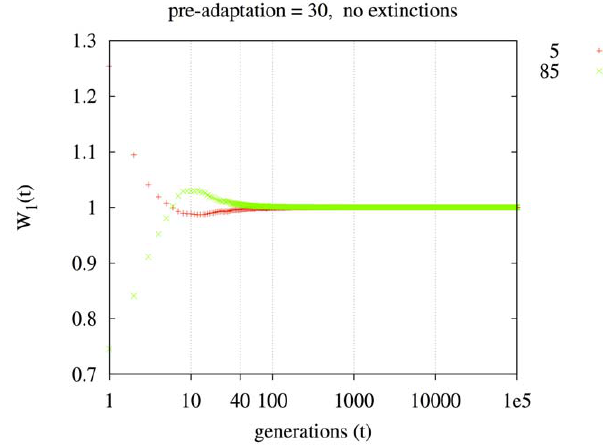
Figure 5. An initially better-adapted lineage (red, a =5) has a higher 1-fitness, W 1 t ð Þ , for t # 5. However, a lineage that produces more high-fitness mutants (green, a =85) attains a higher 1-fitness,